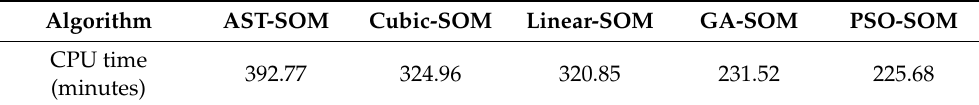
Table 10. The average CPU time of all comparative methods under ten independent runs.